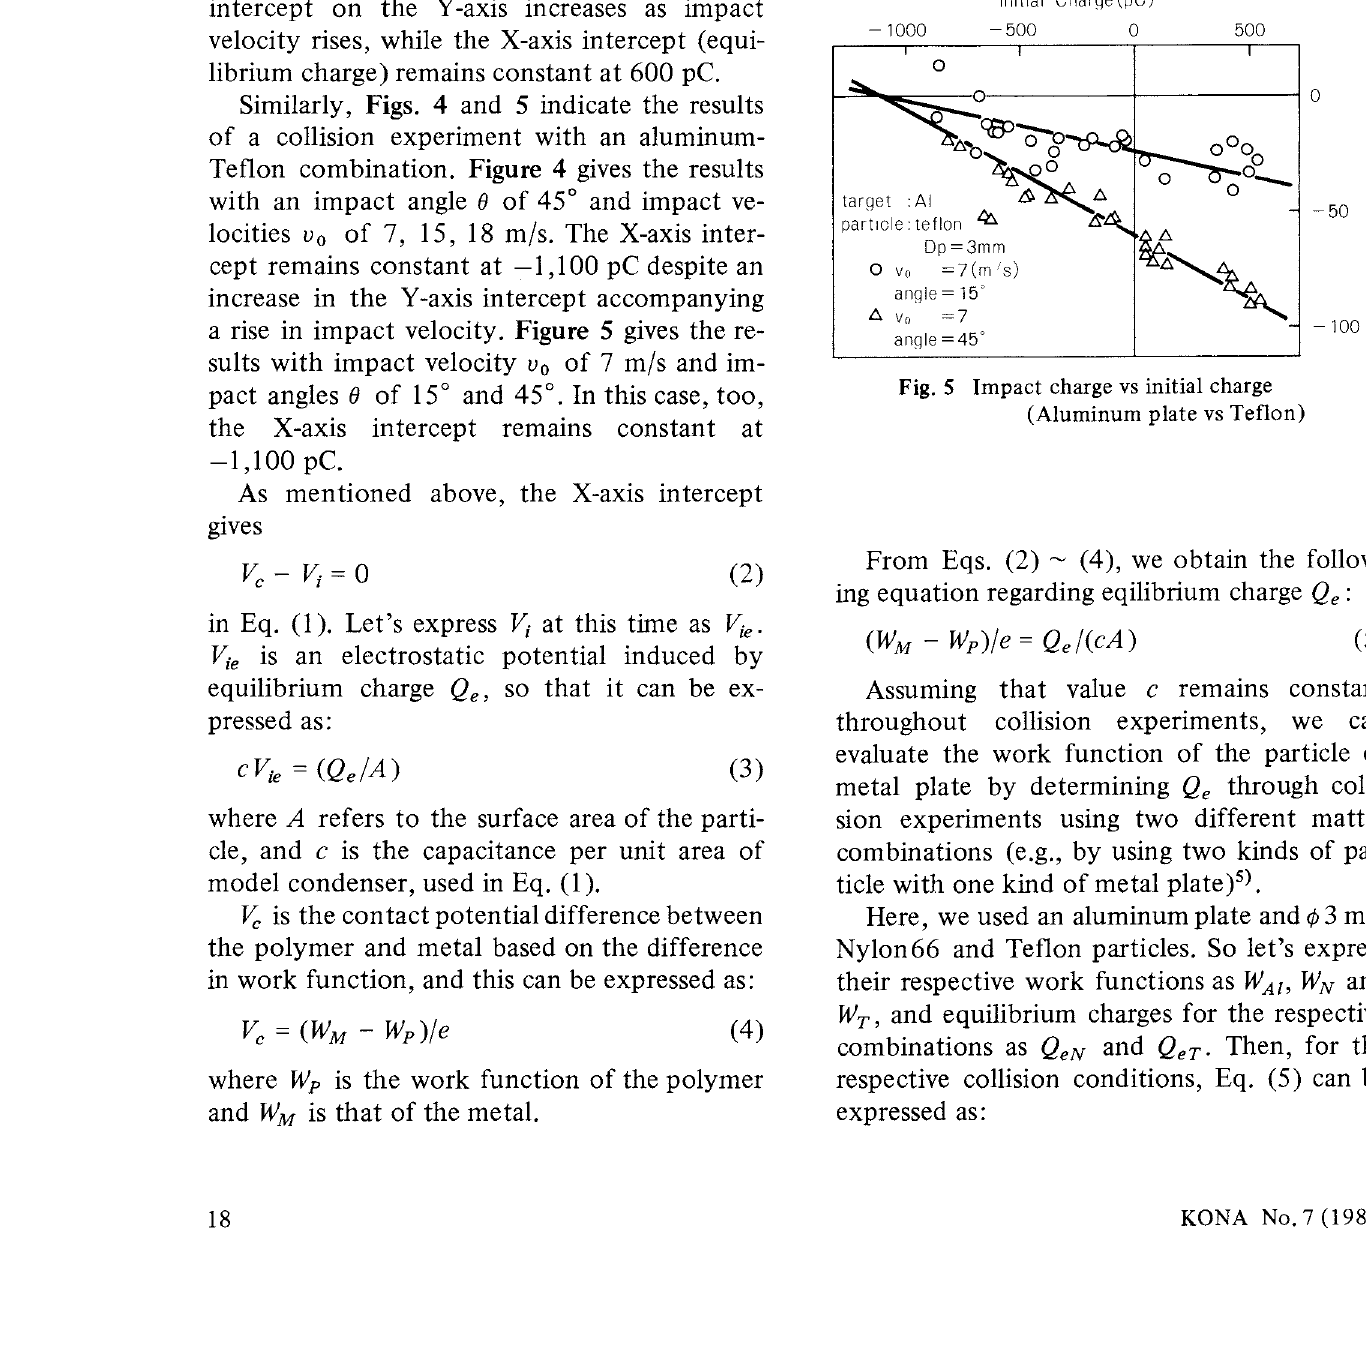
Fig. 3 Impact charge vs initial charge (Aluminum plate vs Nylon 66)